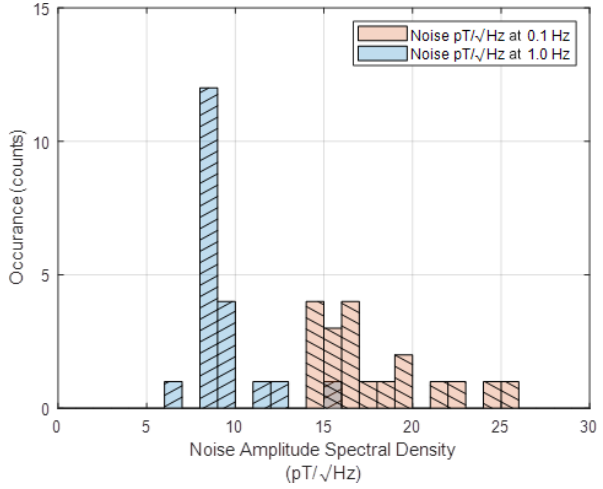
Figure 14. Histograms of noise distribution for 20 cores. Bin √ 16pT / Hz includes cores from both